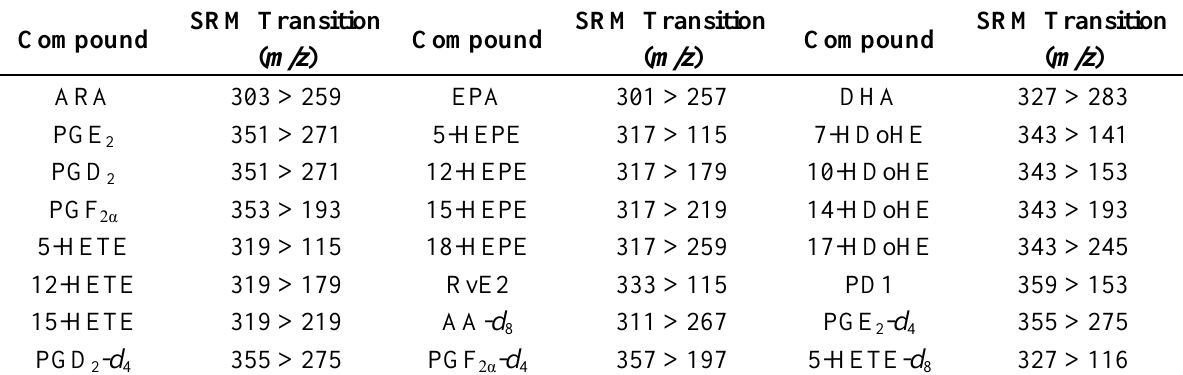
Table 2. Selected reaction monitoring (SRM) transitions of fatty acid